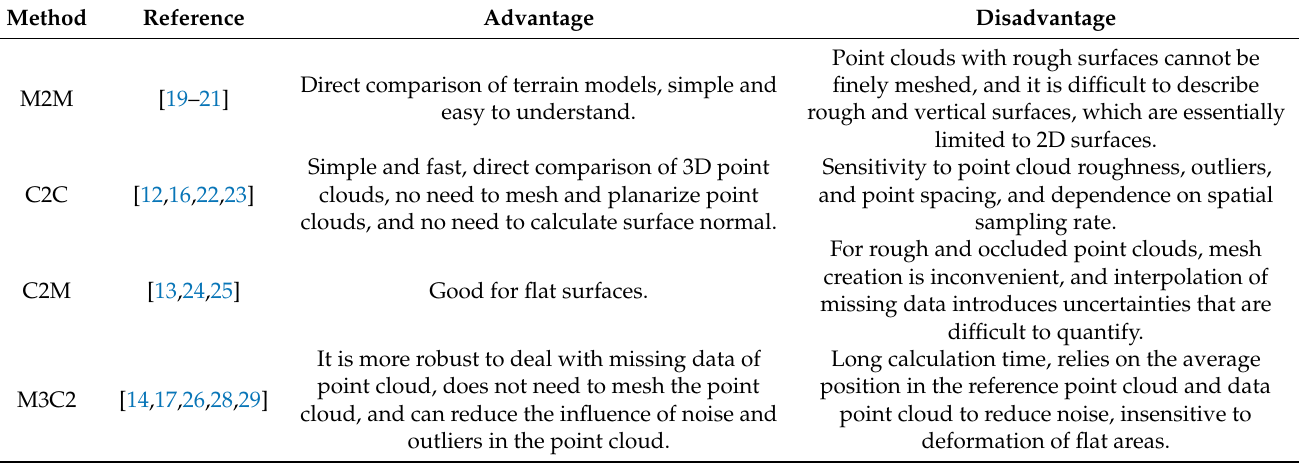
Table 1. Comparison of point cloud ranging